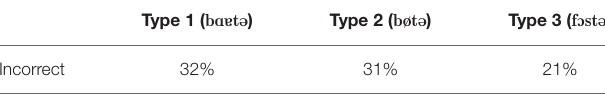
TABLE 10 | Proportions of incorrect answers of nonces in Experiment 2.